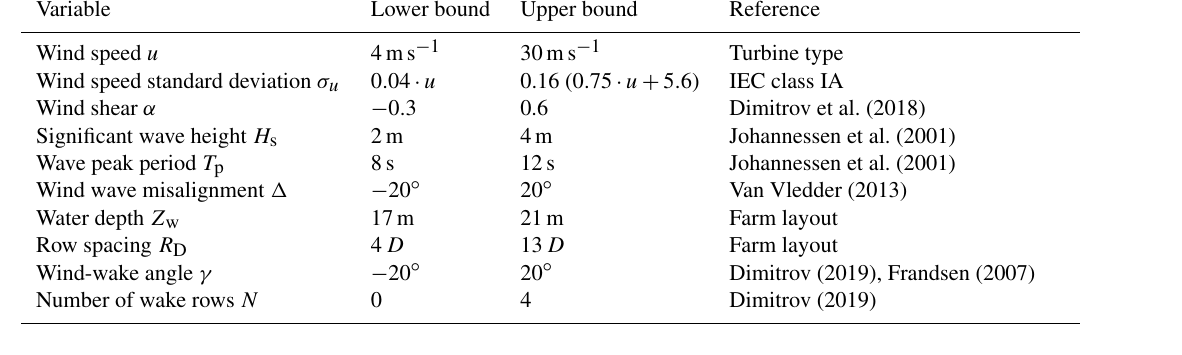
Table 1. Sampling conditions of variables considered for creating a simulation database including references used for the selection. D is rotor diameter.